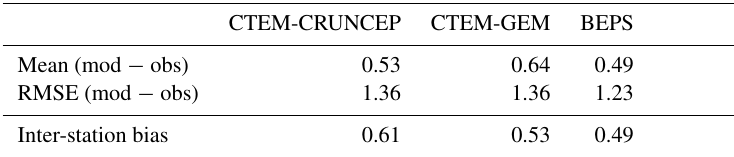
Figure 12. The seasonal cycle of the optimized NEE from GEOS-Chem using three different prior estimates of NEE from CTEM-GEM, CTEM-CRUNCEP, and BEPS (indicated as well) in comparison to the optimized NEE from CT2013B integrated over the 11 TransCom land regions. Table 5. The mean differences and root mean square errors (RMSEs) (in ppm) of the a posteriori CO 2 fields, based on CTEM-CRUNCEP, CTEM-GEM, and BEPS fluxes, with respect to TCCON data for July 2009 to June 2010. Station-to-station error is also